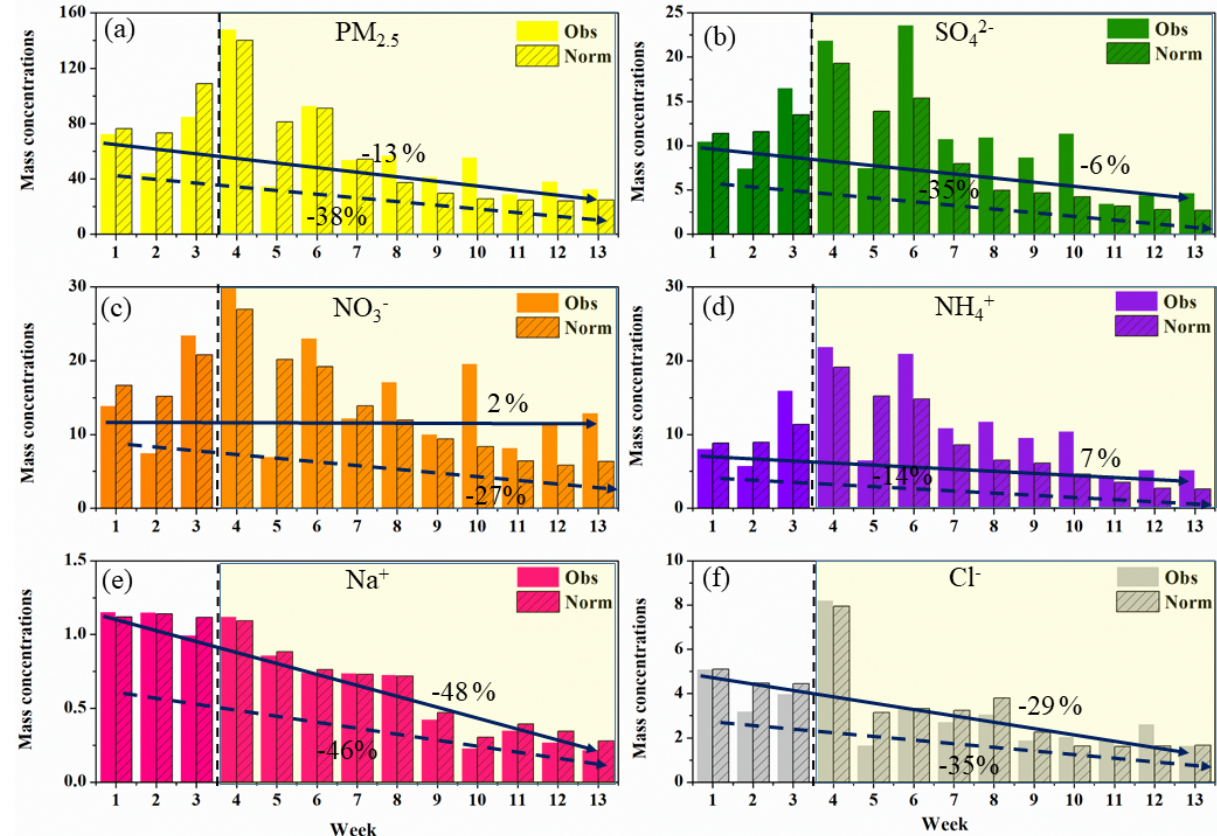
Figure 3. Observed and deweathered weekly concentrations and changes in PM 2 . 5 and water-soluble ions during 1 January–31 March. The solid black line and dotted line represent the decrease ratio of observed concentration and simulated concentration from pre-COVID to post-COVID, respectively. The white background denotes the changes in gaseous pollutants before COVID-19, while the faint yellow one represents the chemical components after the COVID-19